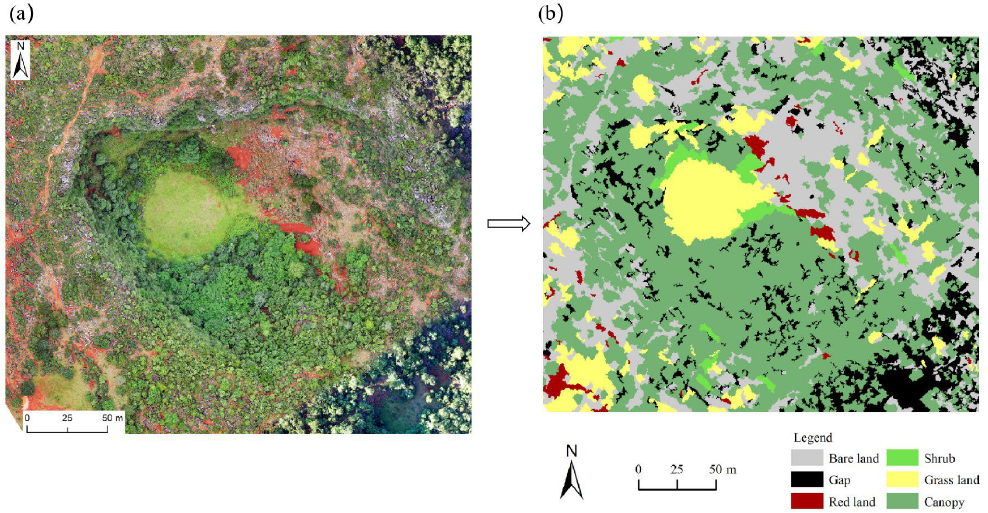
Figure 7. The canopy information extraction from Bajiaxiantang tiankeng. ( a ) The original image; ( b ) The result of extracting the canopy.